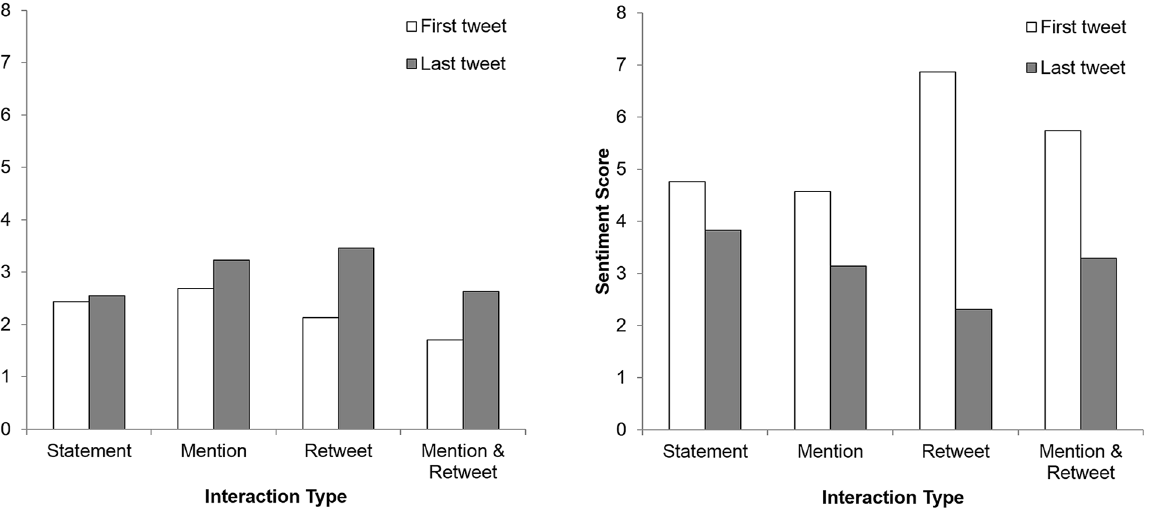
Fig 3. Average sentiment scores for four repeated interaction types (statement, mention, retweet, and mention & retweet) within the first 48 hours of the Domino Pizza's crisis, prior to the CEO's public apology. White bars and black bars indicate average sentiment scores of the first tweet and the last tweet, measured by Linguistic Inquiry and Word Count,